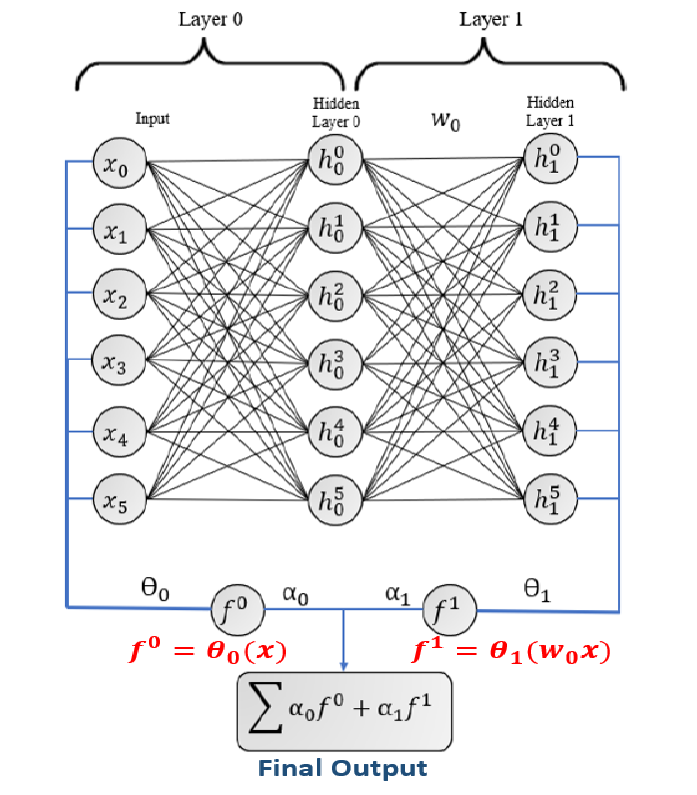
Figure 2. A 2 layer HBP